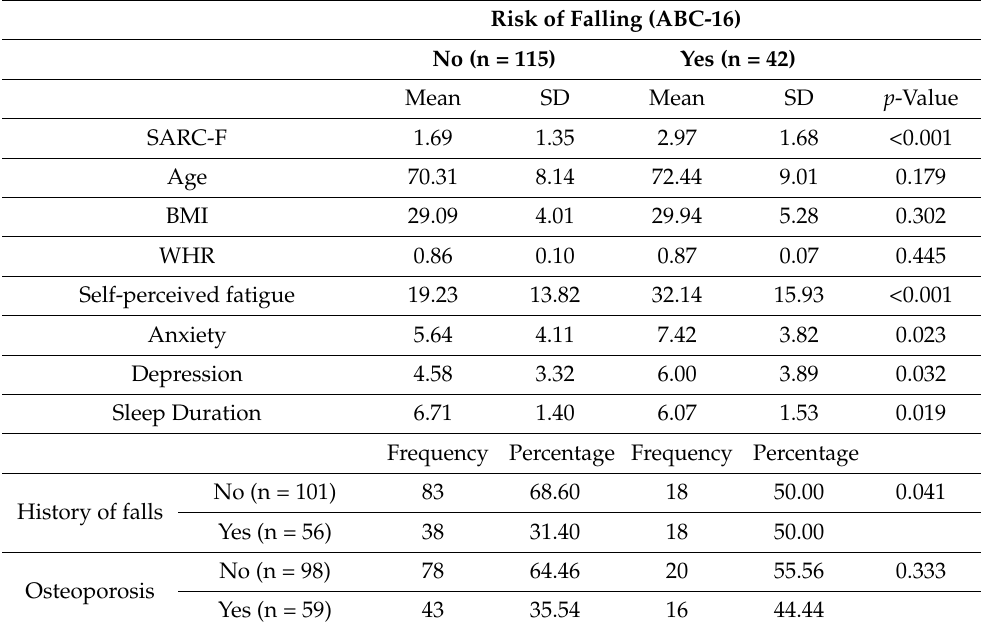
Table 3. Individual differences in SARC-F and possible confounders regarding the risk of falling (ABC-16).